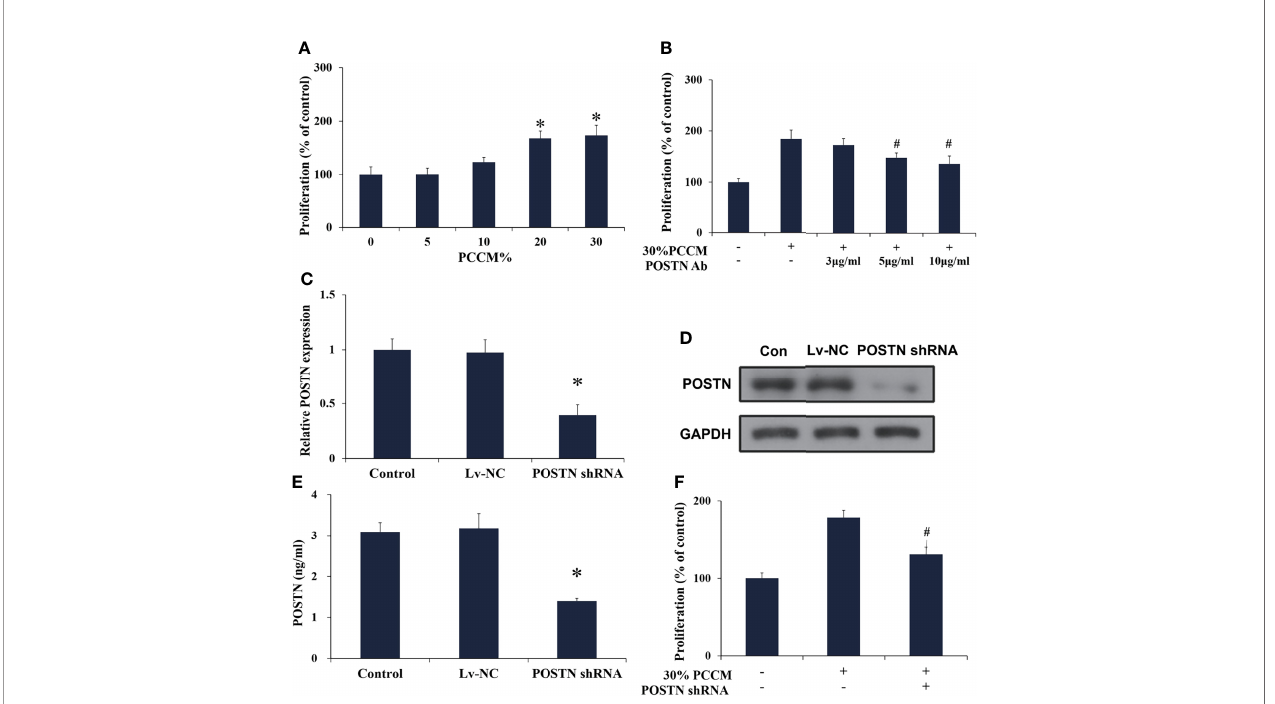
FIGURE 6 | PCa cell-derived POSTN promotes proliferation of osteoblasts. (A) hFOB cells were incubated with various concentrations of PC cell (MDA PCa 2b)- conditioned medium (PCCM) for 48 h and proliferation was assessed. (B) hFOB cells were incubated with 30% PCCM supplemented with various concentrations of POSTN monoclonal antibody for 48 h, and proliferation was assessed. (C) MDA PCa 2b cells were transfected with control shRNA lentivirus (Lv-NC) or POSTN shRNA lentivirus (POSTN shRNA). The expression of POSTN was detected by real-time PCR. (D) MDA PCa 2b cells were transfected with control shRNA lentivirus (Lv-NC) or POSTN shRNA lentivirus (POSTN shRNA). The expression of POSTN was detected by Western blotting. (E) The levels of POSTN in MDA PCa 2b cell medium were detected by ELISA. (F) hFOB cells were incubated with 30% PCCM from control or POSTN-knockdown MDA PCa 2b cells. Proliferation was assessed after 48 h. * p < 0.05 compared with the control; # p < 0.05 compared with the OBCM-treated group.